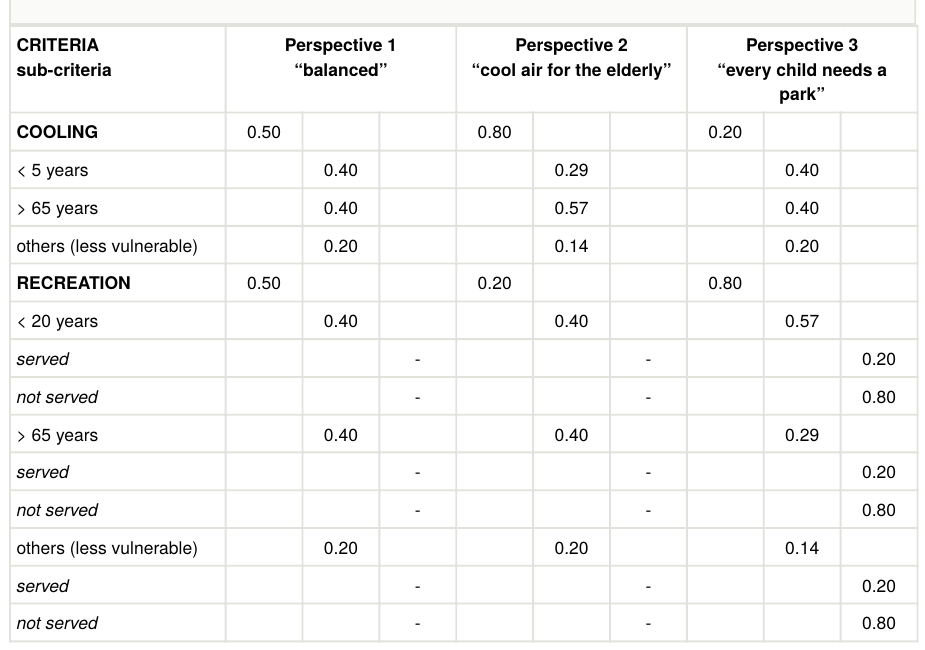
The three illustrative perspectives and respective combinations of weights considered in the multi- criteria analysis for the two ES (criteria) and the di ff erent categories of bene fi ciaries based on